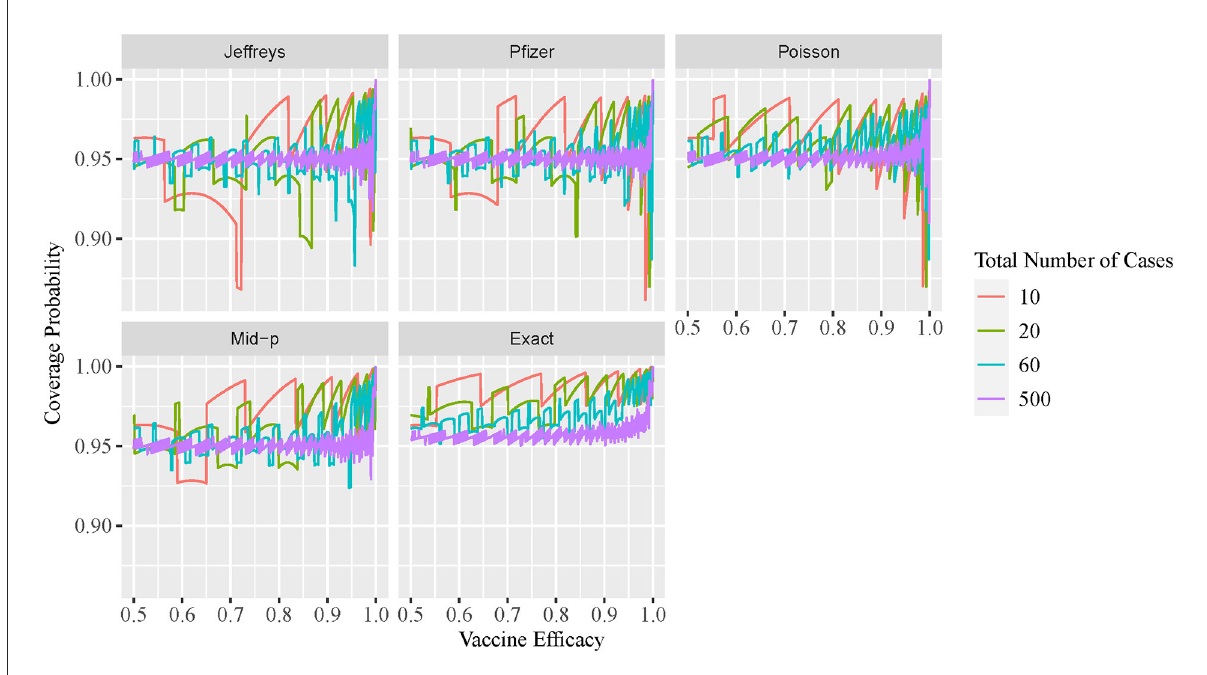
FIGURE1 Line plot of coverage probability for different VE intervals.